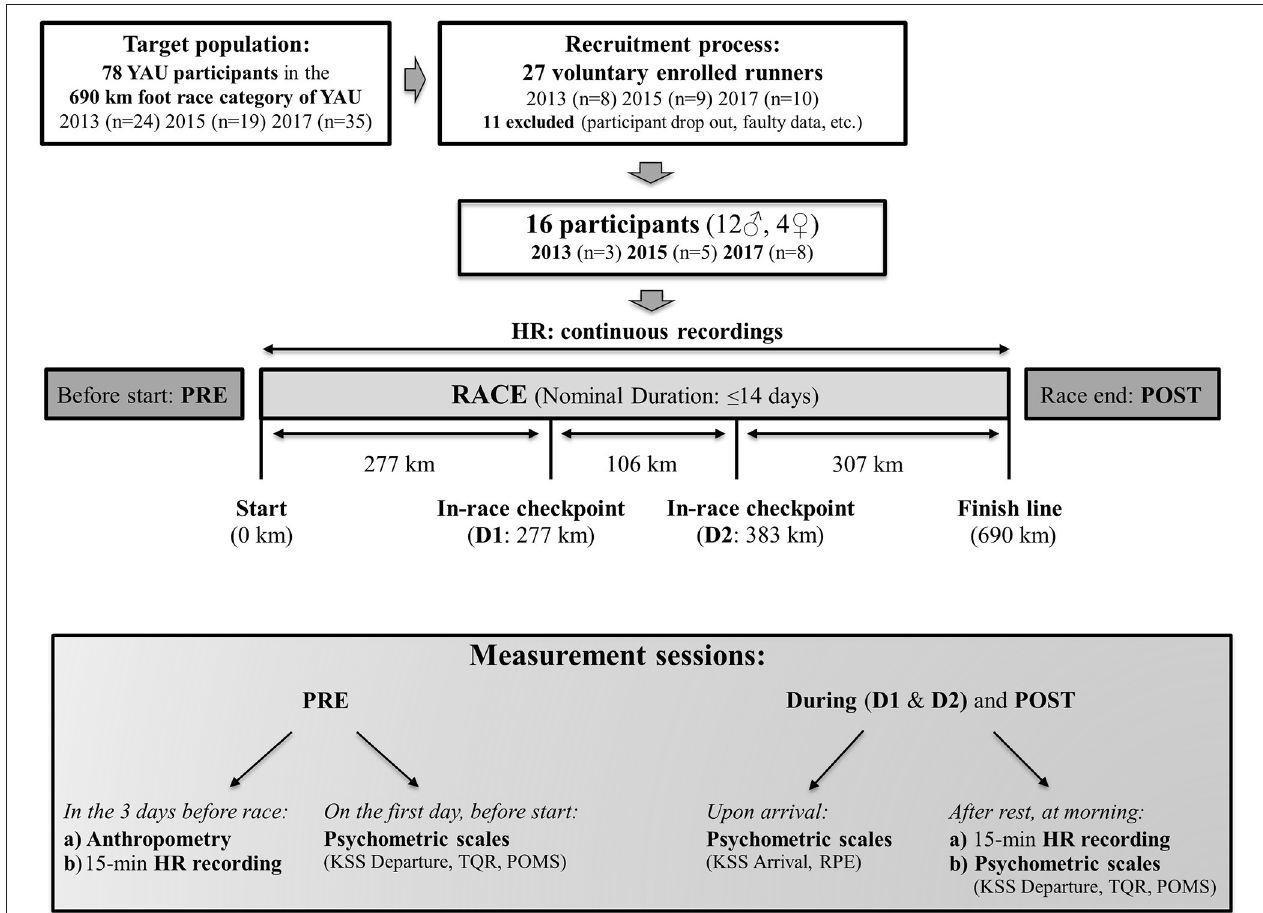
FIGURE 2 | Experimental protocol. Schematic representation of the study protocol and experimental procedure employed in all three YAU races of 2013, 2015, and 2017, except for psychometric assessment (included only in the 2015 and 2017 races).